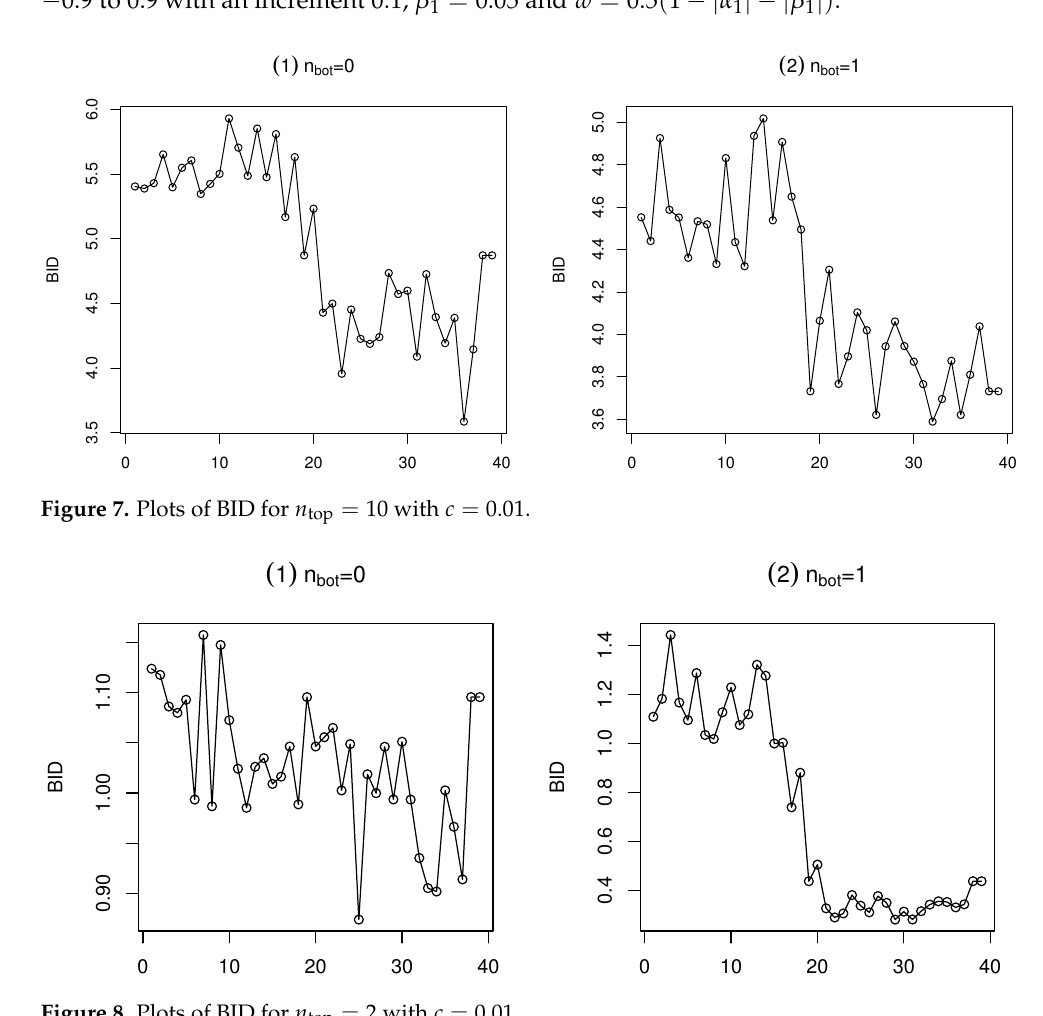
Figure 8. Plots of BID for n top = 2 with c =